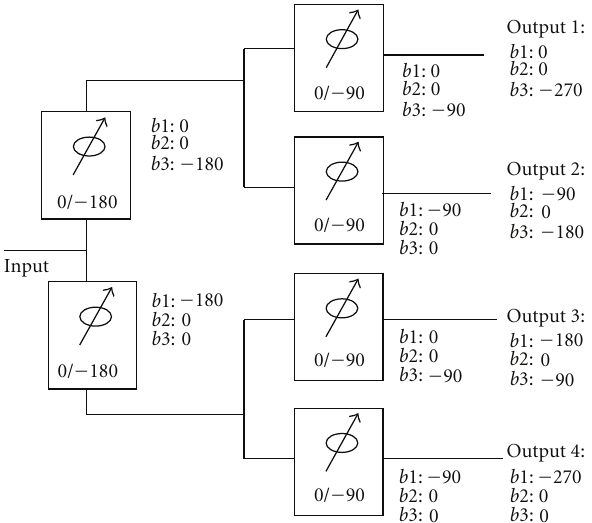
Figure 7: Phase shifter configuration to obtain 3 beams, the two extreme and the central.